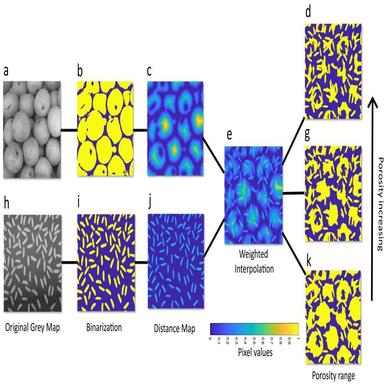
Texture interpolation by weighted averaging of the normalized distance maps, (a and h) original gray maps, (b and i) binarized geometries, (c and j) normalized distance maps of the solid space, (e) equally–weighted average of the distance maps, (d, g and k) three realizations made by changing the threshold level that controls the porosity.